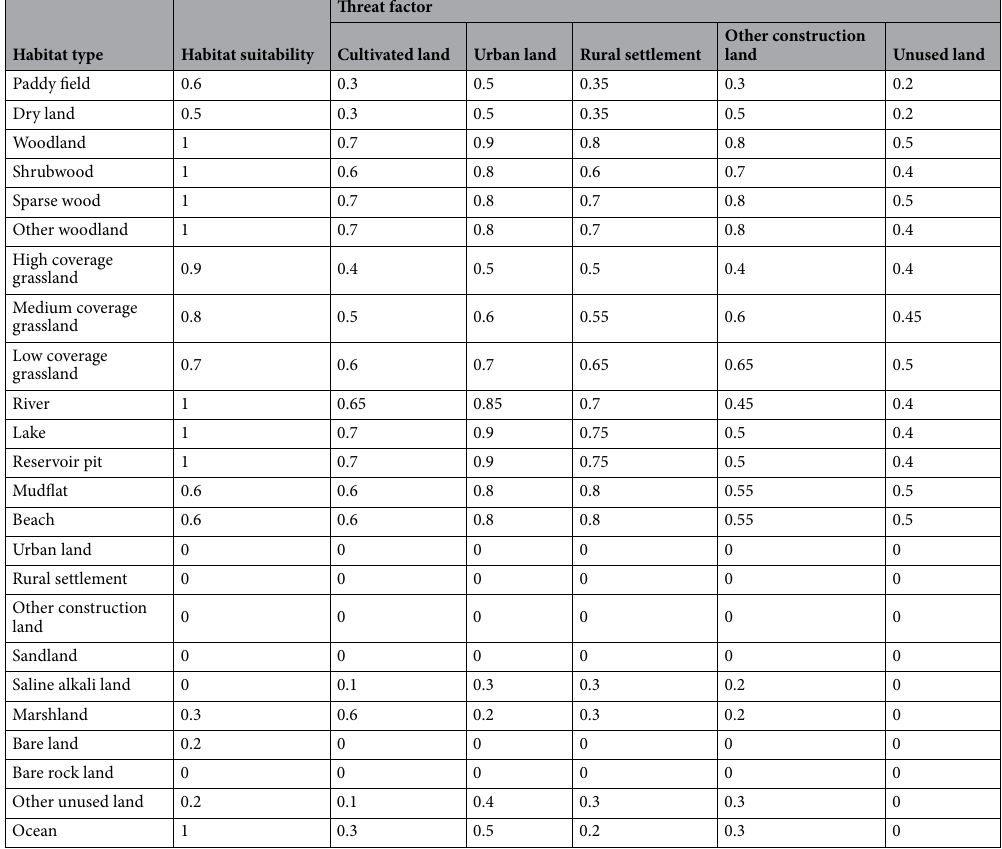
Table 3. Sensitivity of habitat types to each threat